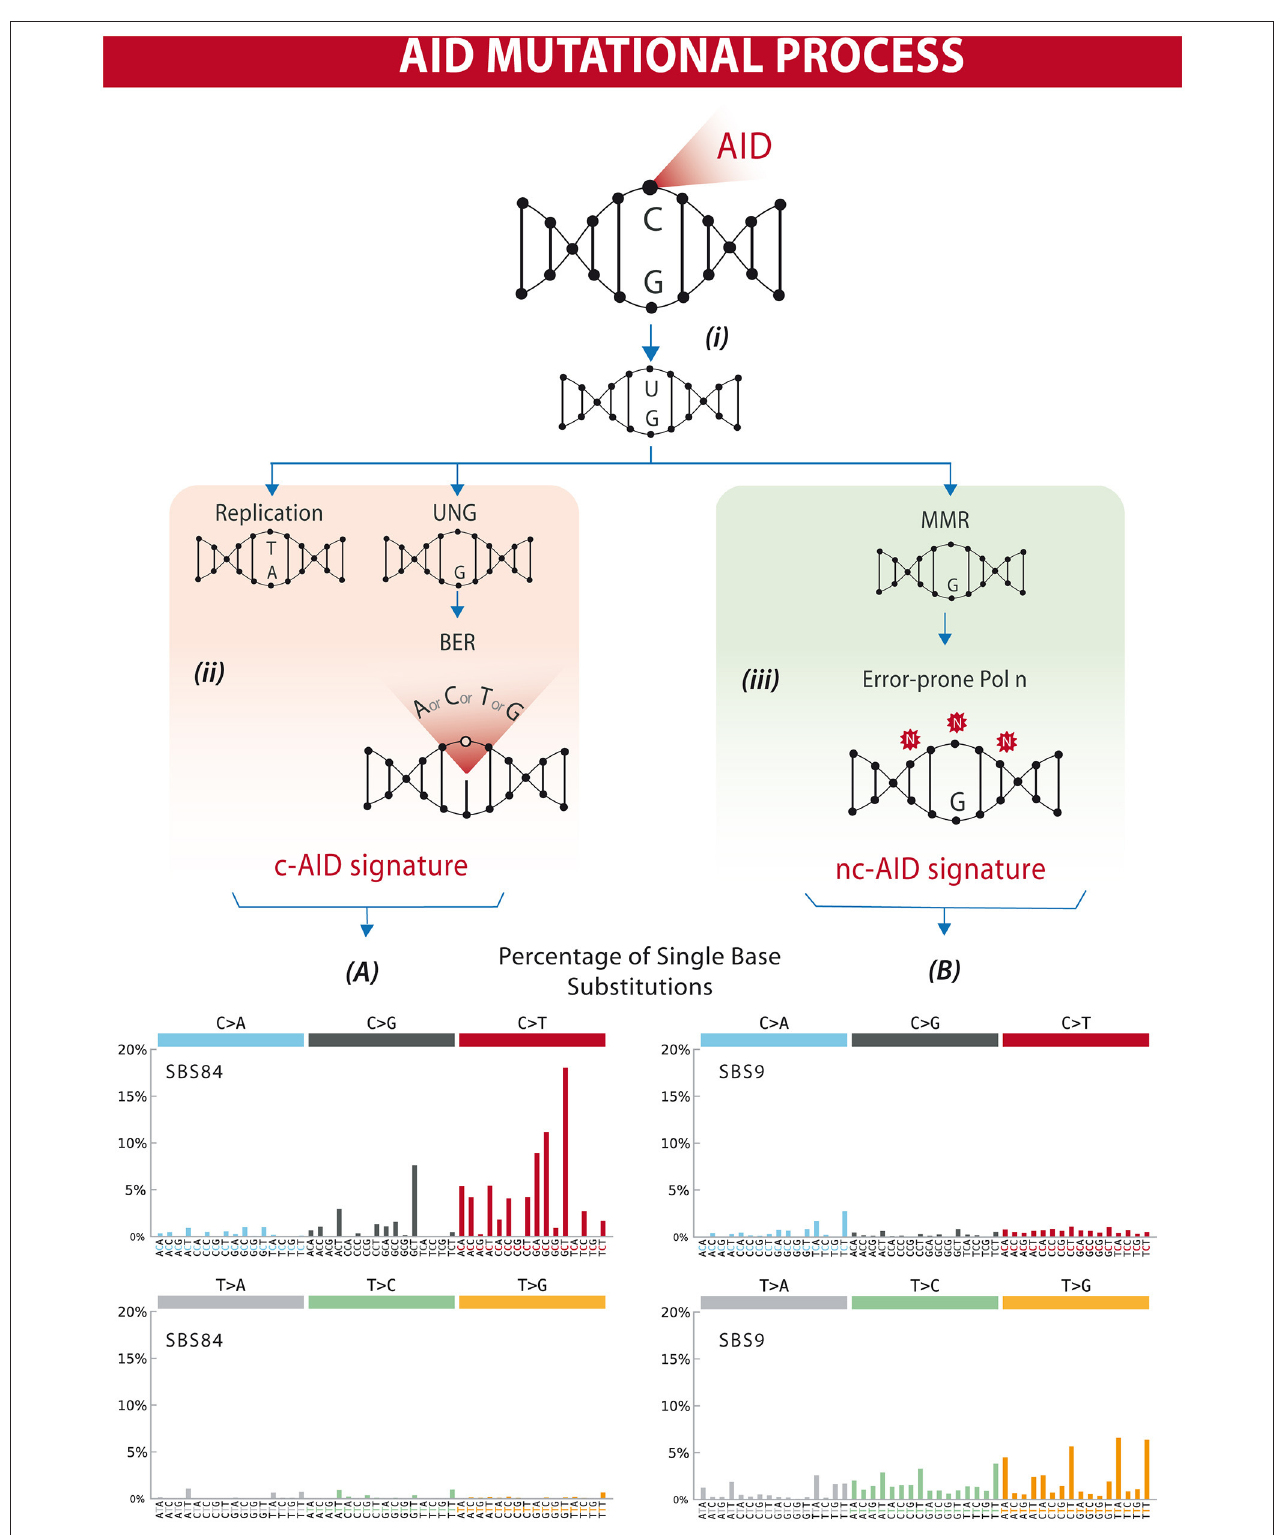
FIGURE 1 | Differential processing of AID lesions. (i) AID deaminates cytosine residues on single-stranded DNA that is exposed during transcription, converting C (cytosine) into U (uracil). (ii) The U-G (guanine) mismatch can be processed through different pathways. Either by replication that will result in a C > T transition or by